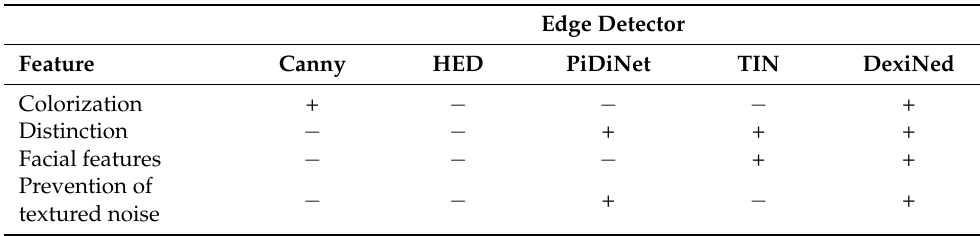
Table 2. Qualitative analysis of edge detectors for generated RGB images with positive (+) or negative ( − ) assessment of the output image features regarding